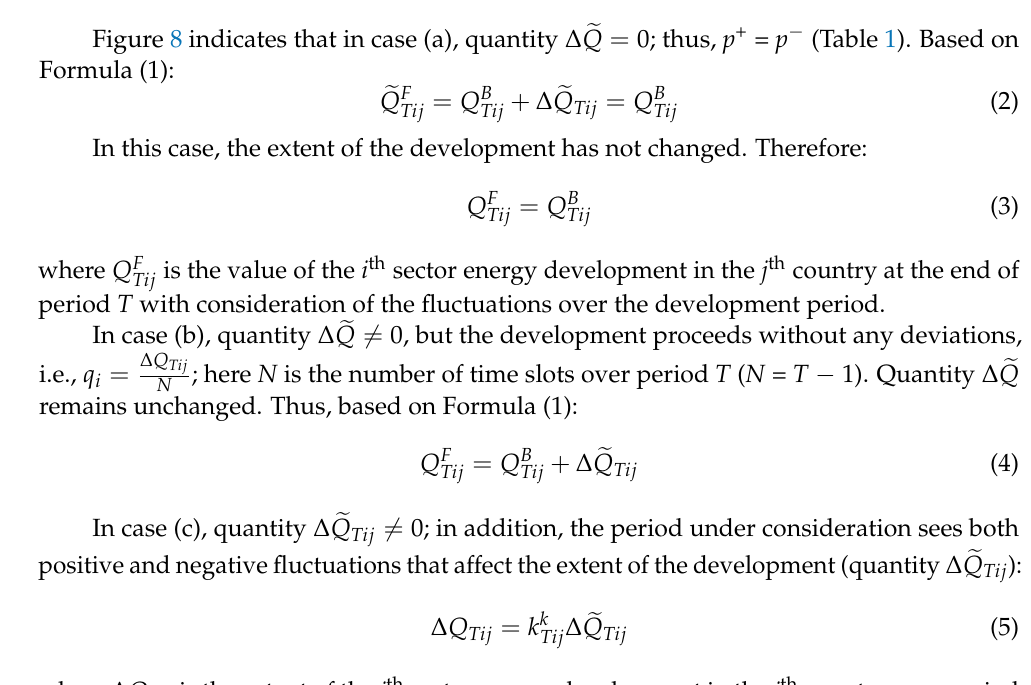
Figure 8. Exemplary cases of sectoral energy development: ( a ) is when positive and negative changes of economic sector energy development was regular during period T and its scale was similar; ( b ) only possive changes were observed ( c ) only negative changes (source: compiled by the authors).